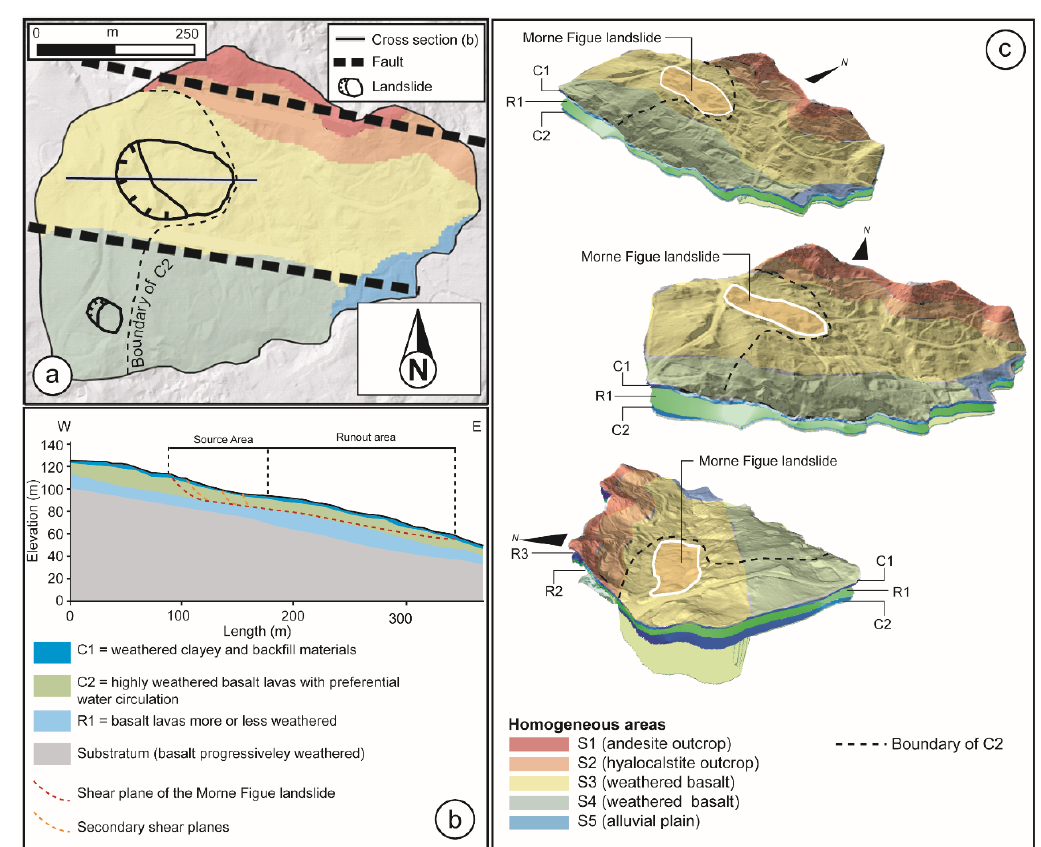
Figure 9. Geological model of the Morne-Figue area. ( a ) Location of homogeneous areas identified by resistivity data analysis, field observations and boreholes; ( b ) 2D cross-section representing the different materials selected for physical- based modeling; ( c ) interfaces introduced for ALICE ® (hillshade map is produced with Litto3D DTM, IGN, 2010).